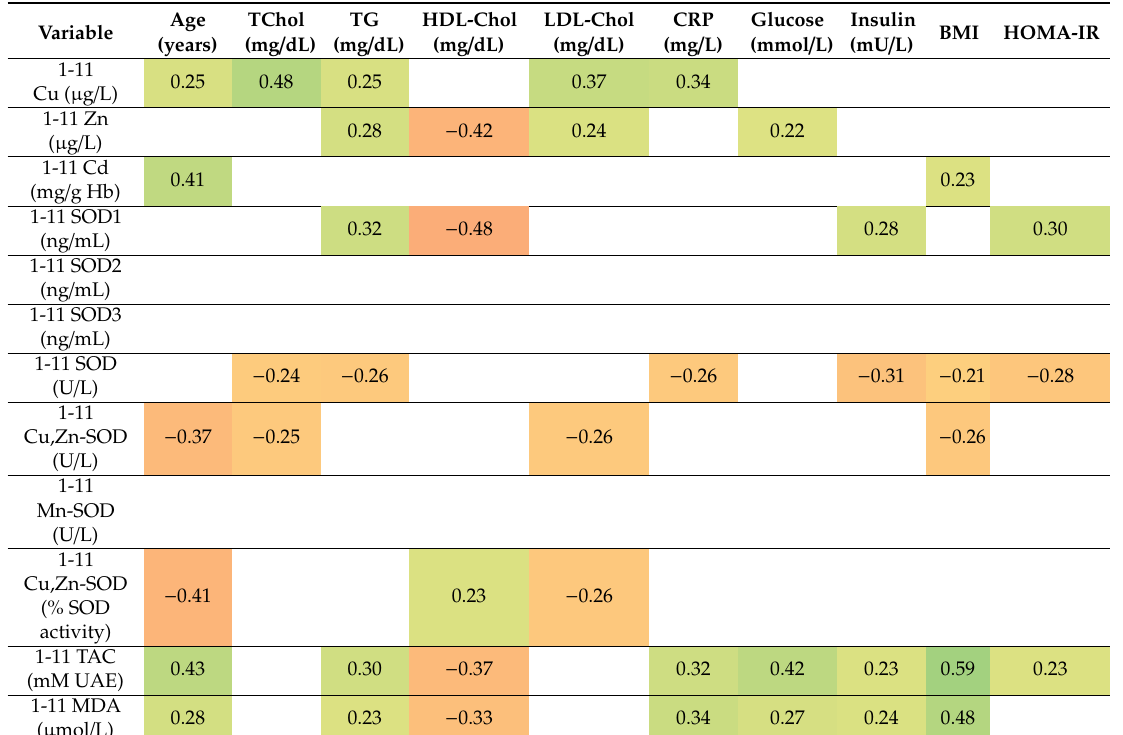
Table 6. Spearman correlation matrix between selected variables, in the entire population sample ( n =